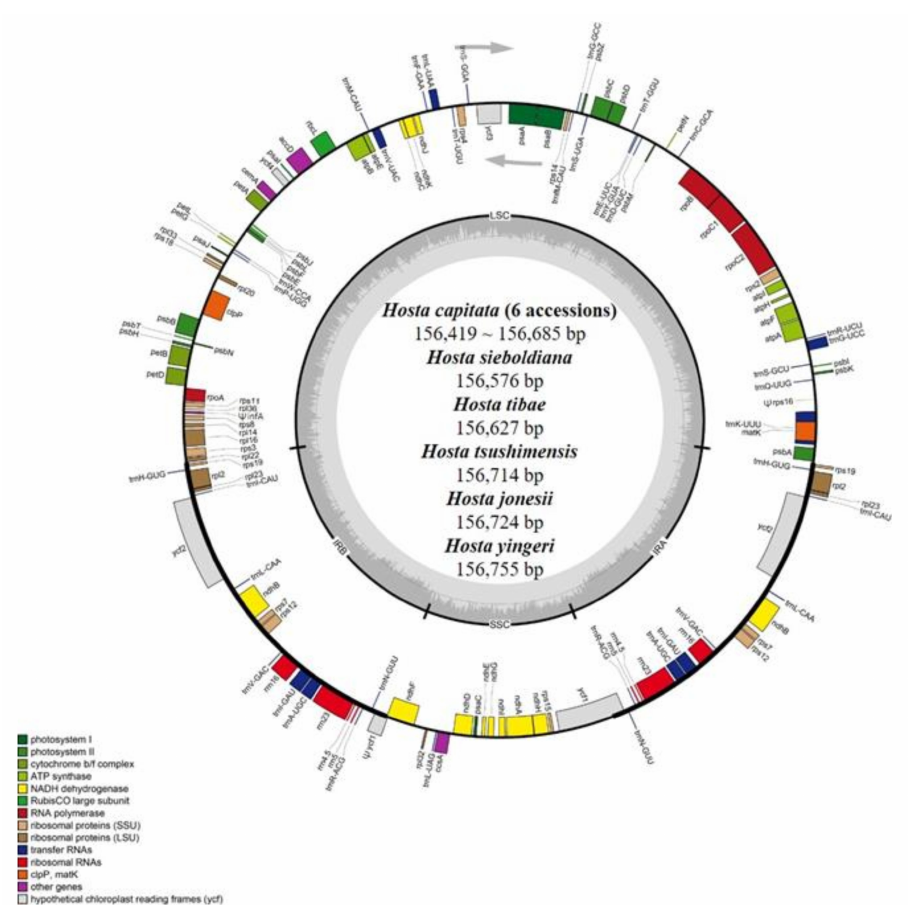
Figure 1. The 11 Hosta plastomes. The genes located outside the circle are transcribed clockwise, while those located inside are transcribed counterclockwise. The gray bar area in the inner circle denotes the genome’s guanine–cytosine (GC) content, whereas the lighter gray area indicates the genome’s adenosine–thymine (AT) content. LSC, SSC, and IR indicate large single-copy, small single-copy, and inverted repeats,